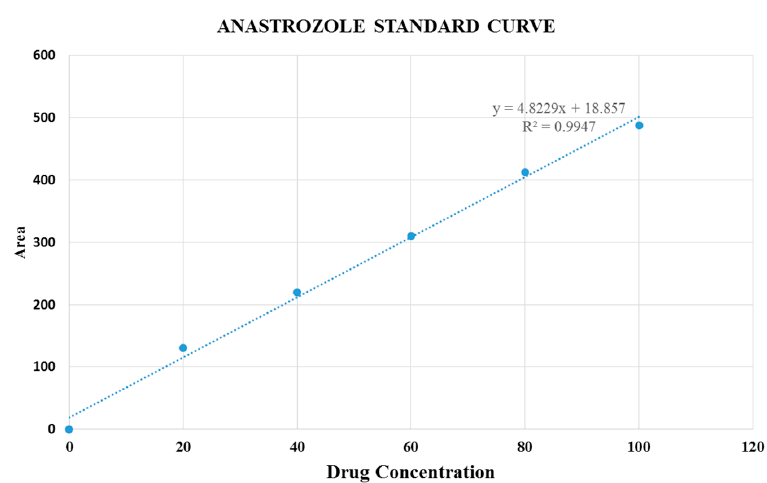
Figure 9. Gemcitabine standard curve.